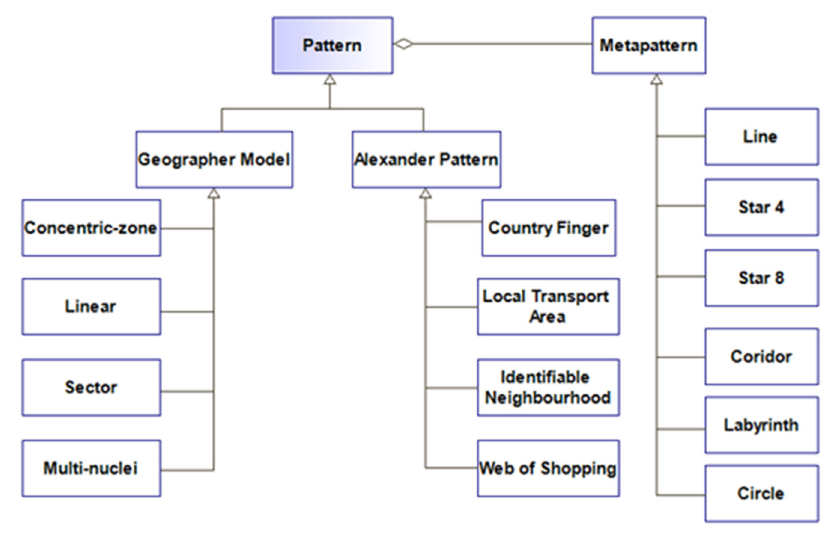
Figure 5. Basic spatial meta-pattern (UML class diagram).